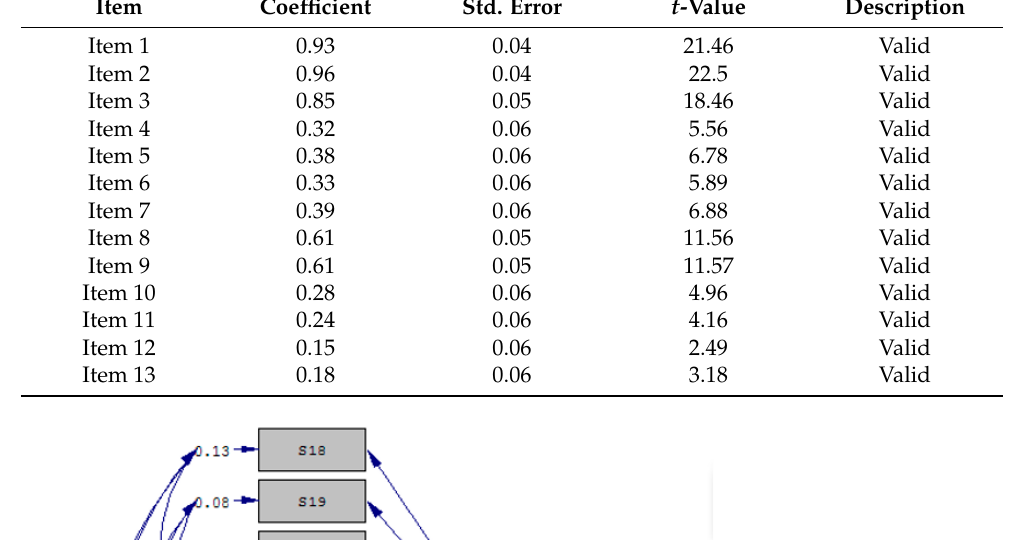
Table 3. Results of CFA of the Islamic Religious Moderation Attitudes Scale.